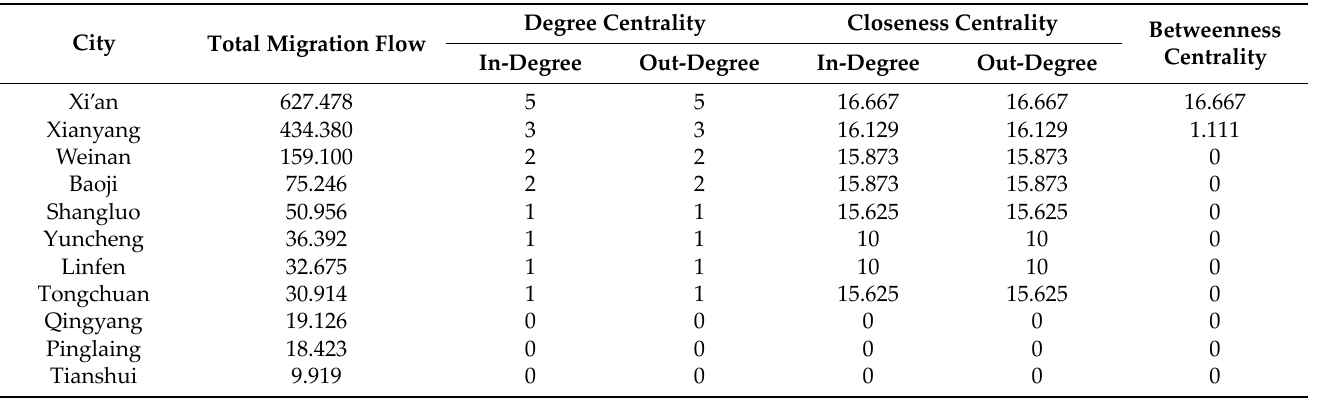
Table 3. Total migration flow and